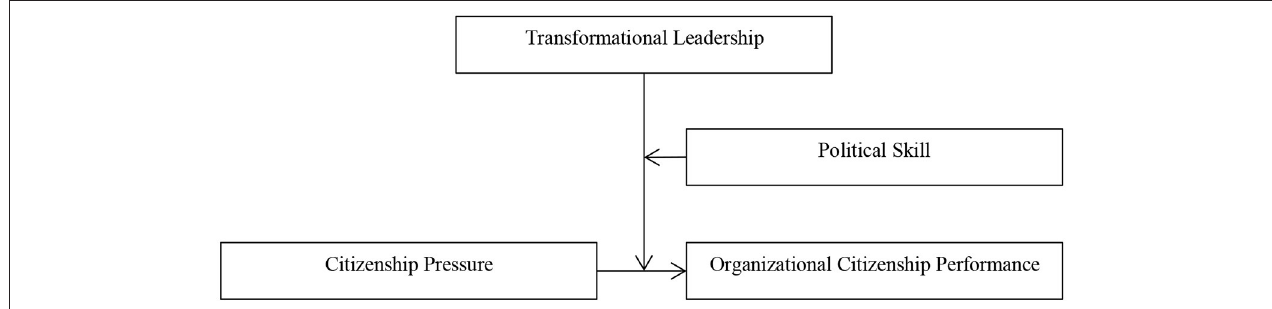
FIGURE 1 | Theoretical